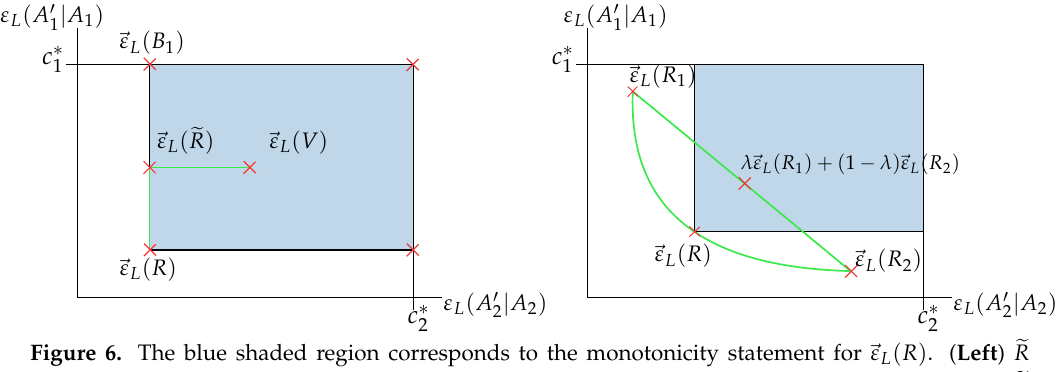
Figure 6. The blue shaded region corresponds to the monotonicity statement for (cid:126) ε L ( R ) . ( Left ) (cid:101) R is a mixture of R and B 1 . We can also get an observable V by mixing the second marginal of (cid:101) R with B 2 and, thus, reach every point in the blue shaded region. ( Right ) (cid:126) ε L ( R ) is componentwise convex. Therefore, the mixture of the points (cid:126) ε L ( R ) and (cid:126) ε L ( R ) is always in the monotonicity region corresponding to (cid:126) ε L ( R )